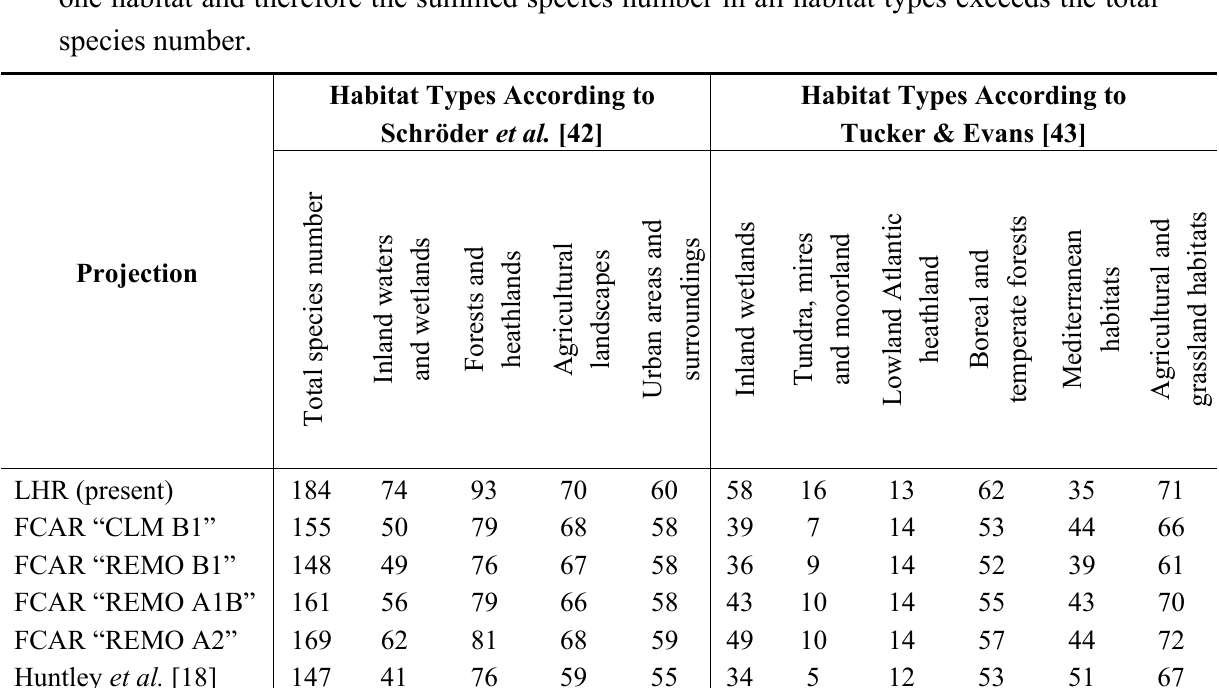
Table 4. Absolute number of species in the LHR, the FCARs, and in Huntley et al. [18] (as